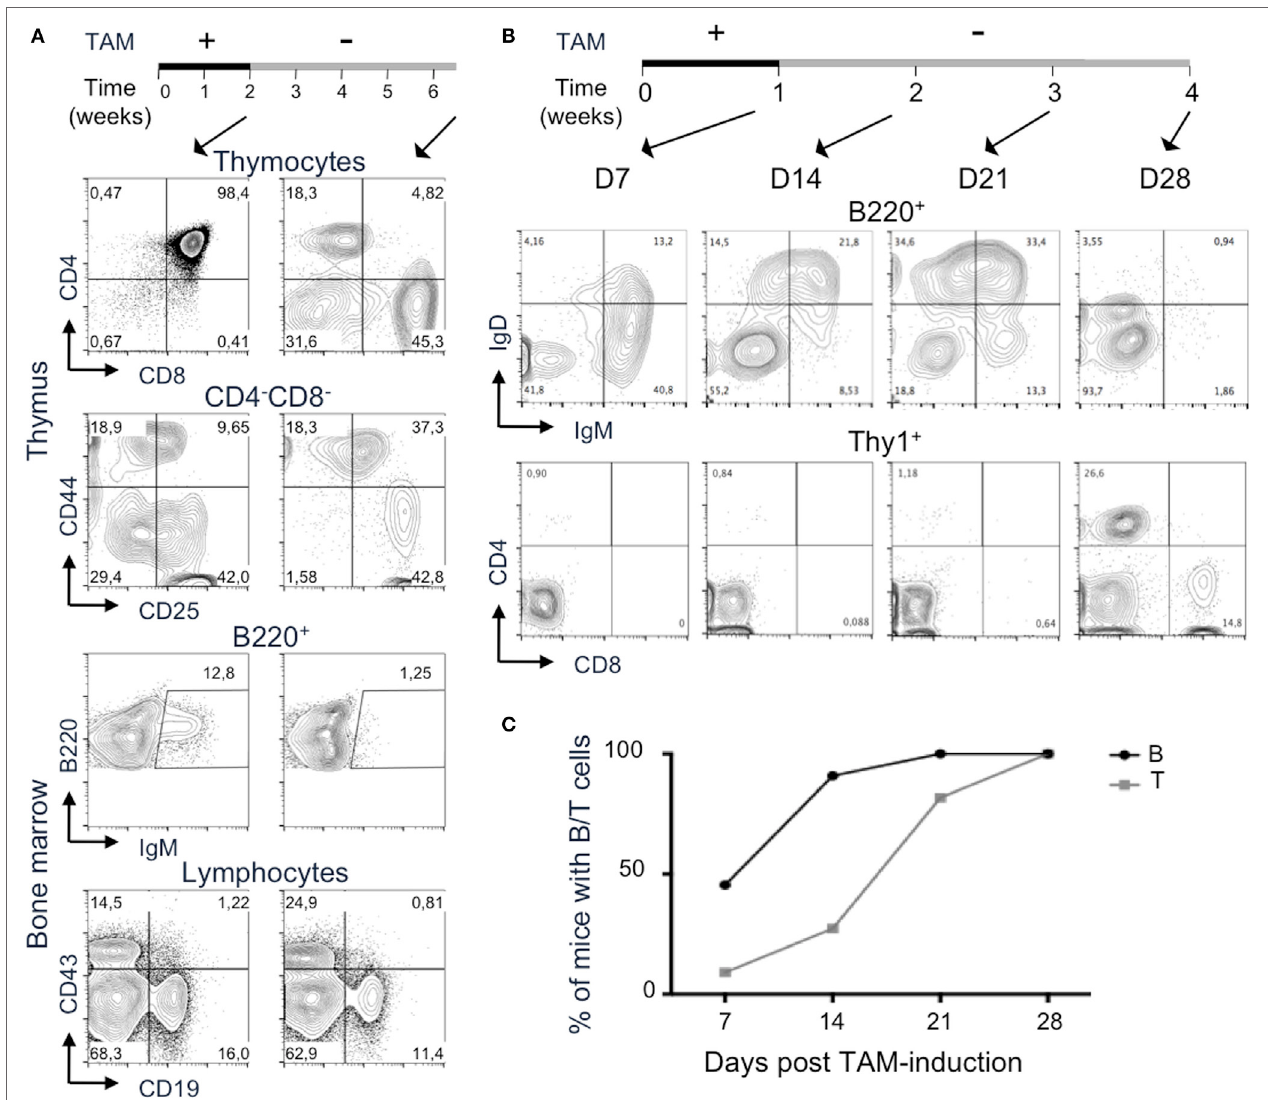
FigUre 5 | Termination of 4-hydroxytamoxifen (TAM) administration prevents further lymphocyte development. (a,B) The upper lines represent the timelines of normal and TAM food administration in Tg endoR2 − / − animals, arrows indicate the time at analysis. (a) Administration of TAM during 2 weeks is sufficient to induce mature lymphocytes differentiation (left panels), while withdrawal of TAM for 4 weeks arrests lymphoid development. Representative FACS profiles of developing T cells in the thymus (upper panels) and B cells in the bone marrow (bottom panels). Data are representative of 3 independent experiments. (B) B cell development precedes T cells differentiation. Representative FACS profiles of B220 + peripheral blood mononuclear cell (PBMC, upper panels) and Thy1 + (lower panels) cells, after 1 week of TAM administration (D7) or followed by 1, 2, or 3 weeks of normal food. IgM + and IgD + B cells are observed from the first week of analysis, while only a few CD4 + cells are detected at that stage. Clear CD4 + and CD8 + T cells populations are detected at day 28. Data are representative of three independent experiments. (c) B cells consistently appear before T cells in peripheral blood. Kinetic analysis of B and T cells frequency in blood of Tg endoR2 − / − animals treated along the (B) regimen ( N = 11